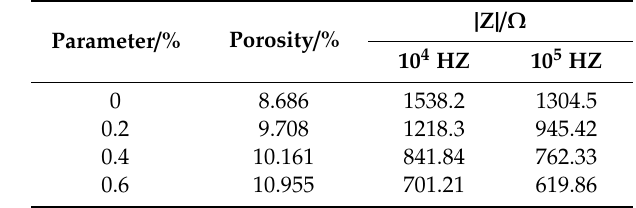
Figure 12. Relationship between porosity and AC impedance at 10 5 Hz; ( a ) represents the filling body with different AEAs at the 7 days curing age; ( b ) represents the filling body with different AEAs at the 28 days curing age. Table 6. Adding sodium abietate (SA), the AC impedance of the filling body for the curing ages of 7 days.